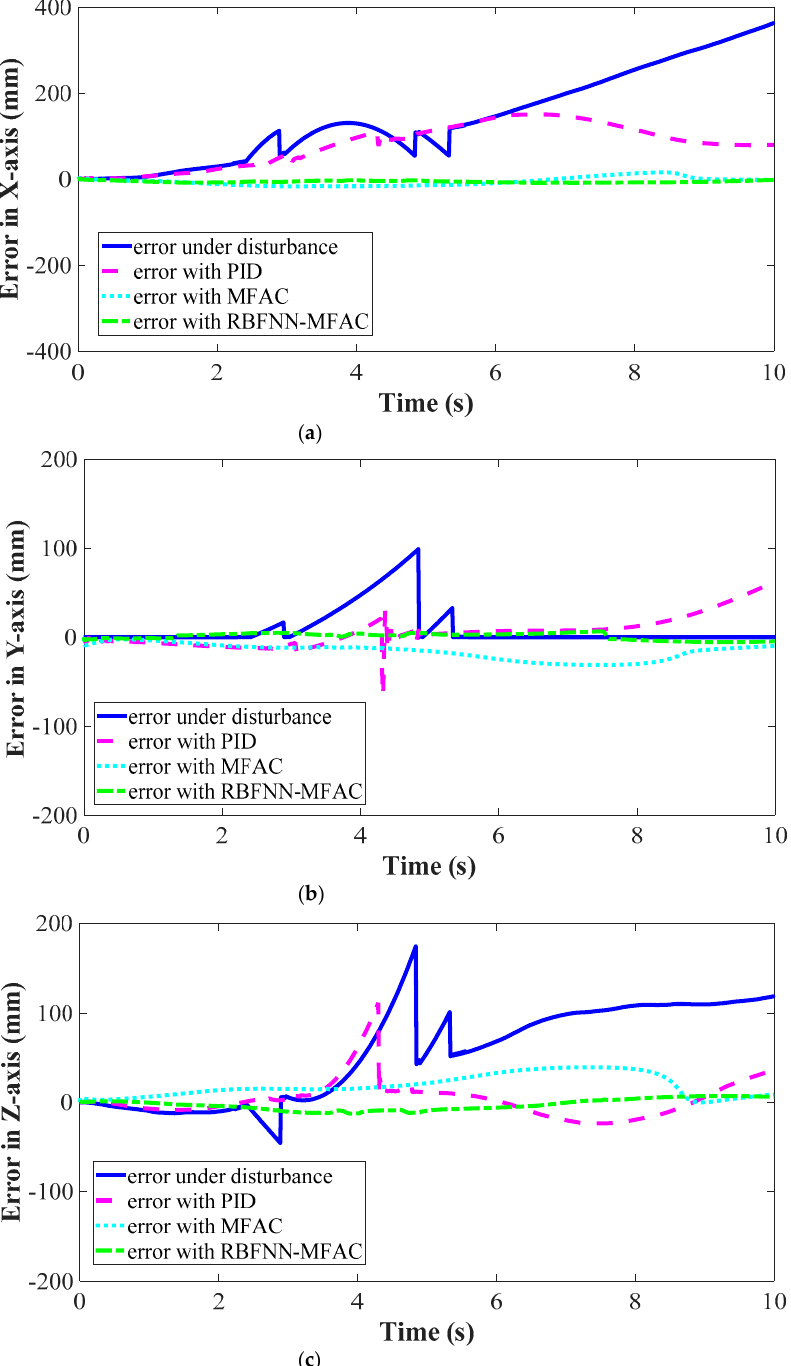
Figure 13. Position Tracking Error along Various Axes of Cartesian Coordinates. ( a ) Position Tracking Error along x Axis; ( e px : average error with PID is 80.1 mm, average error with MFAC is 9.3 mm, average error with RBFNN-MFAC is 5.8 mm). ( b ) Position Tracking Error along y Axis; ( e py : average error when PID is 12.9 mm, average error with MFAC is 15.9 mm, average error with RBFNN-MFAC is 3.5 mm). ( c ) Position Tracking Error along z Axis; ( e pz : average error when PID is 14.2 mm, average error with MFAC is 18.7 mm, average error with RBFNN-MFAC is 5.7